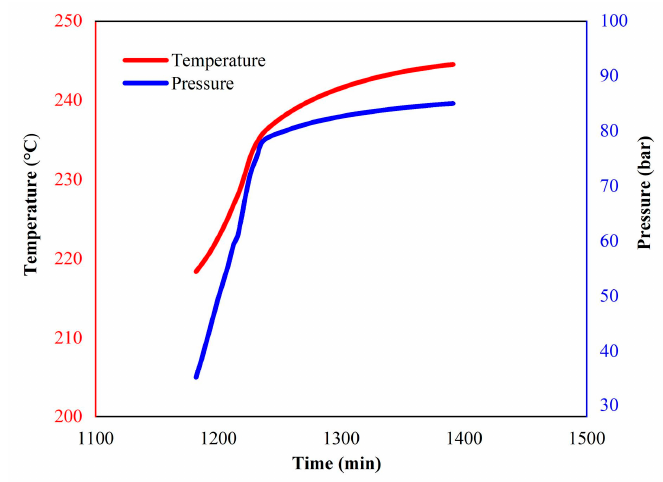
Figure 5. Temperature and pressure versus time (1180–1400 min) curves of LP30 + PFPN.